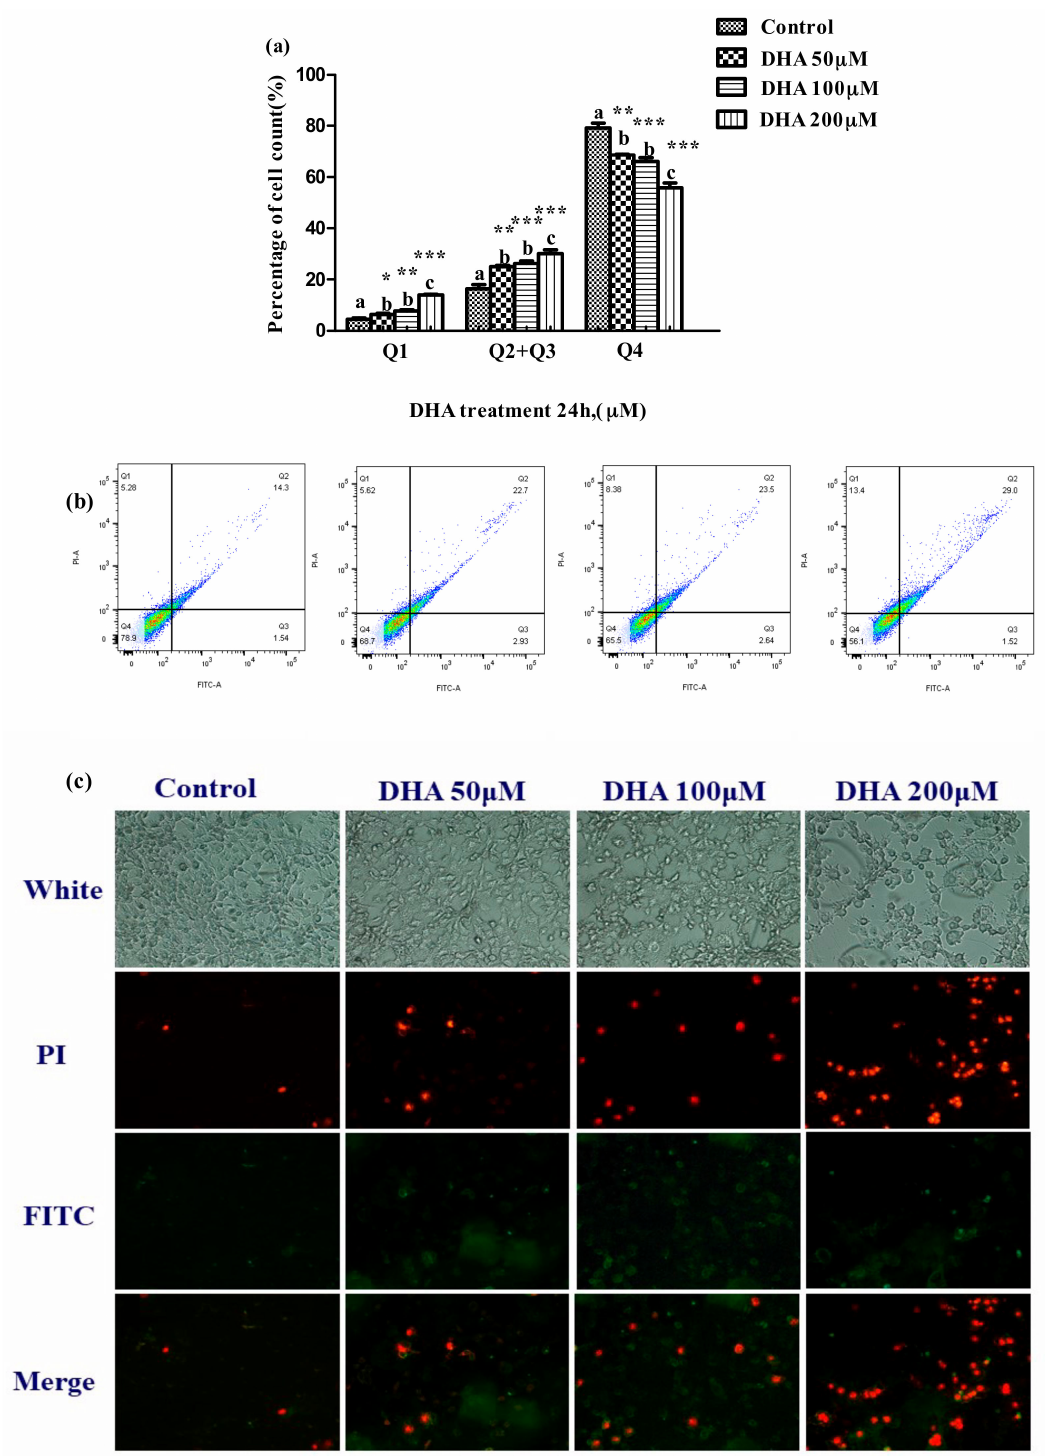
Figure 3. Effect of different concentrations DHA-treated BRL-3A for 24 h on the cell apoptosis. BRL-3A cells were stained with annexin V-FITC and PI after treatment with different concentration DHA, ( a ) the proportion of apoptotic cells was determined by flow cytometry ( n = 3); values are means with SEM, the SEM was presented with vertical bars; means with different letters are significantly different from one another ( p < 0.05) as determined by variance analysis followed by multiple comparisons with LSD post-hoc test; * statistically significant differences vs. control ( p < 0.05); ** statistically significant differences vs. control ( p < 0.01); *** statistically significant differences vs. control ( p < 0.001); ( b ) the fluorescence of apoptotic cells was observed by fluorescence microscope ( n = 3); ( c ) cells were treated as described in Section 2 and analyzed by fluorescence